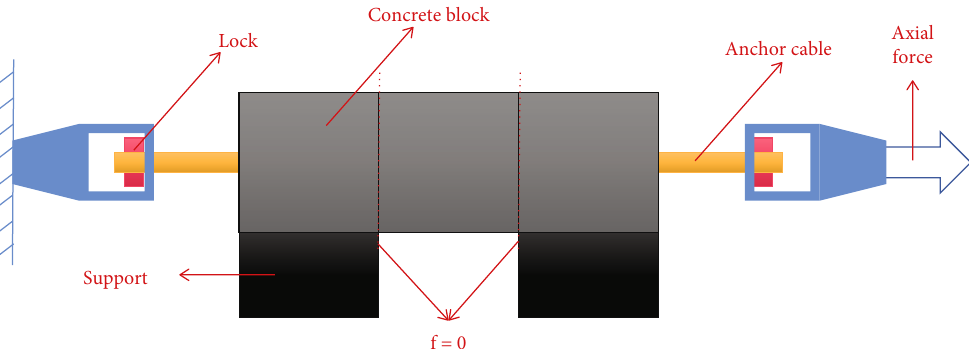
Figure 3: Schematic drawing of tensioning anchor